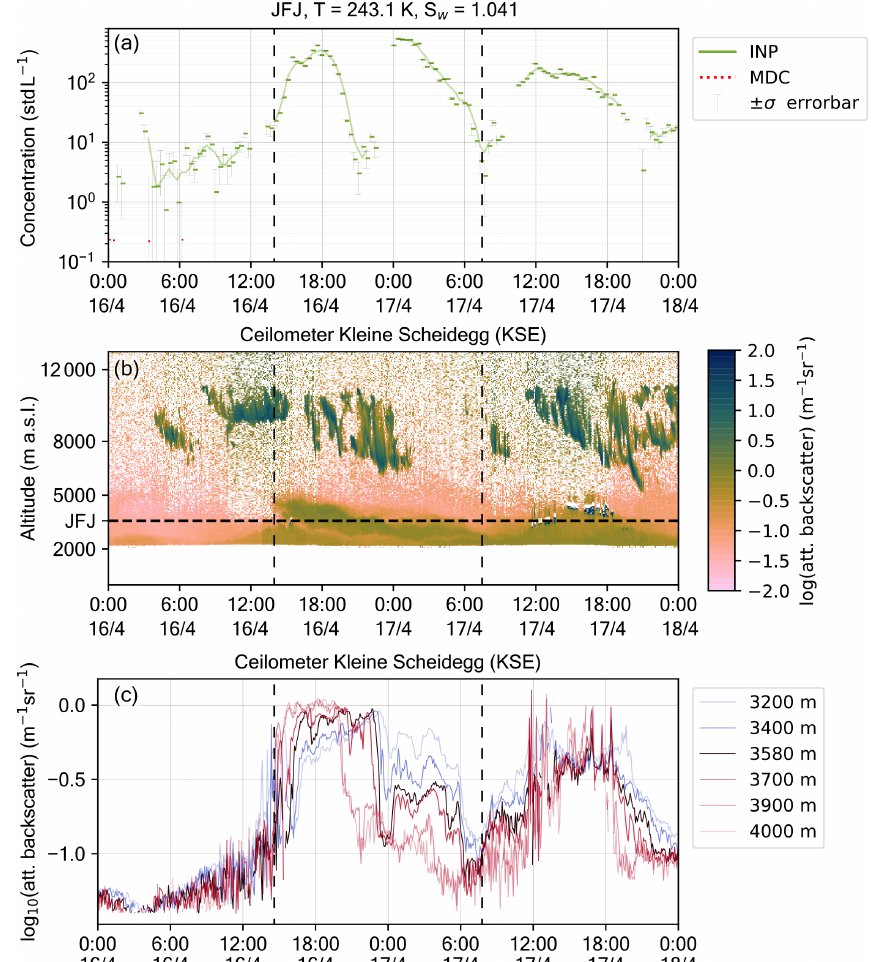
Figure 8. ( a ) INP concentrations and ( b ) vertical profile of the attenuated backscatter from the ceilometer at KSE and ( c ) at selected altitudes similar to the altitude of JFJ with filtering for in-cloud and in-precipitation signals during a classified dust event, starting on 16 April, at 11:26UTC, and ending on 17 April, at 22:21UTC. When an INP measurement is below the minimum detectable concentration (MDC) of 0.236INPstdL − 1 , a red dashed marker is plotted. The horizontal black dashed line indicates the altitude of JFJ in ( b ); vertical black dashed lines provide guidelines to better compare the three